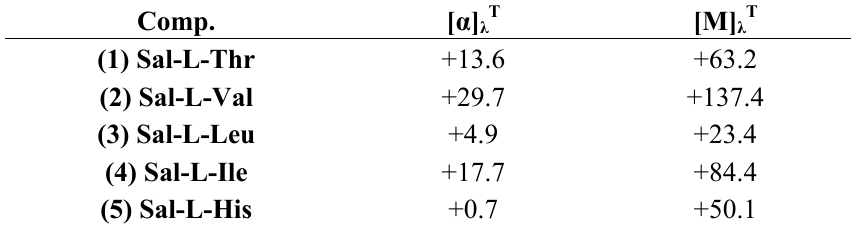
Table 4. Specific and molar rotation of amino acids ionic liquid-supported Schiff